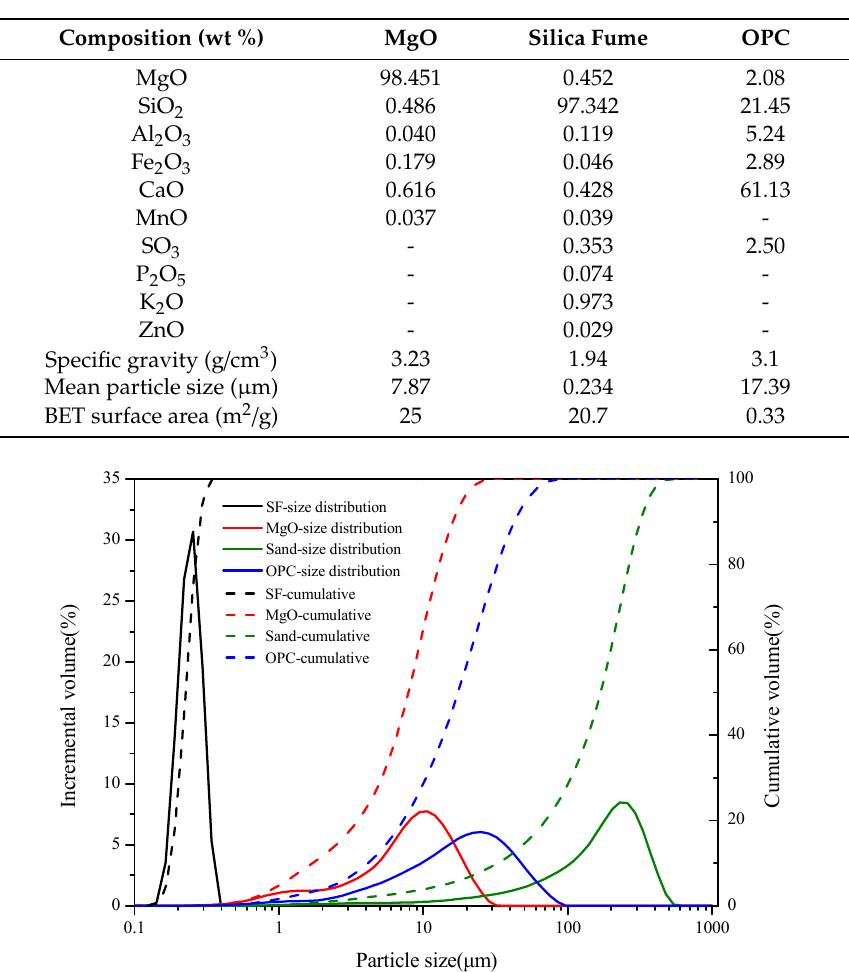
Table 1. Characteristics of the raw materials.